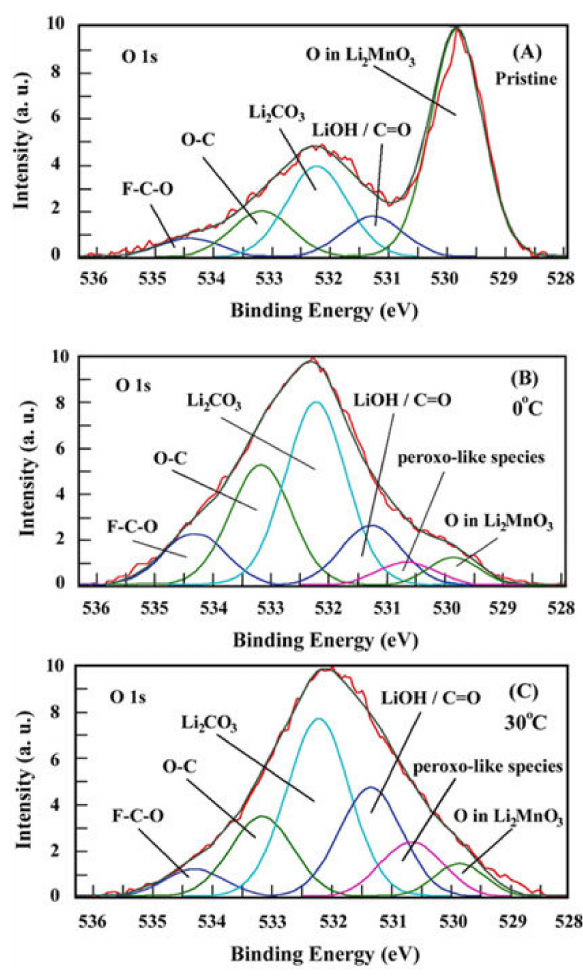
Figure 5. O1s XPS spectra measured from pristine (uncycled) Li 2 MnO 3 electrode ( A ) and those subjected to the 1st charge–discharge cycles at 0 ◦ C and 30 ◦ C, ( B ) and ( C ), respectively. Voltage profiles of these electrodes are shown in Figure